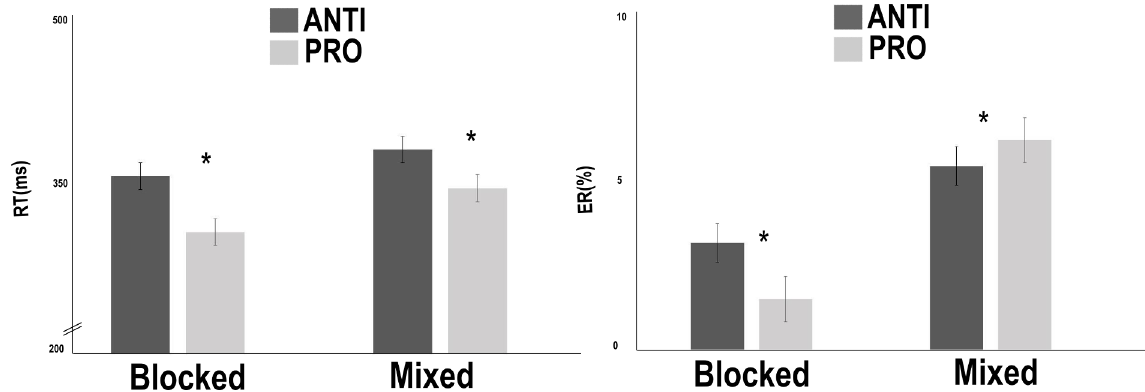
Fig 4. Results of the modified version of the anti-saccade task in the straight-gaze condition. A significantinteraction betweenresponsesuppression and switchingin terms of reactiontimes (RTs). The results showedthat in the blockedcondition, the differences in the RTs and error rates (ERs) betweenthe ANTI and PRO conditions were greater than in mixed